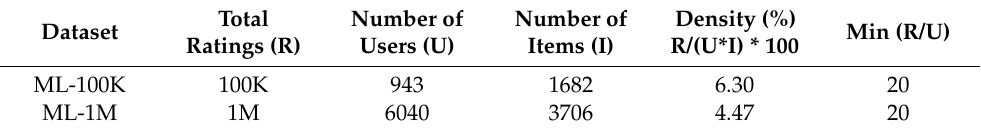
Table 1. Statistics of